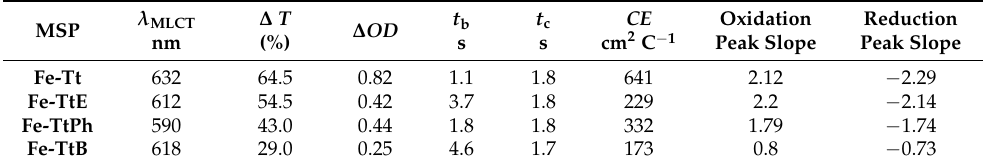
Table 3. Electrochromic performance of Fe-MSPs films: λ MLCT —the wavelength of the MLCT band, ∆ T —optical contrast, ∆ OD —change in optical density, t b —bleaching time (neutral to oxidized state), t c —coloring time (oxidized to neutral state), CE —coloration efficiency.